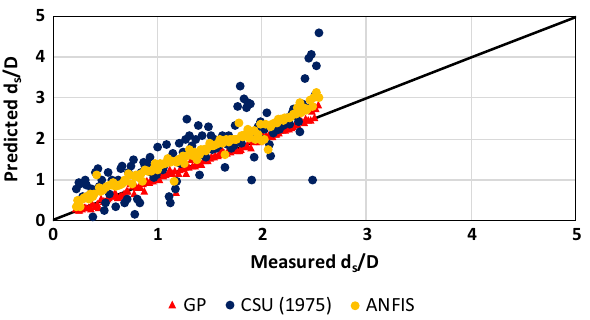
D versus CSU (1975) s /